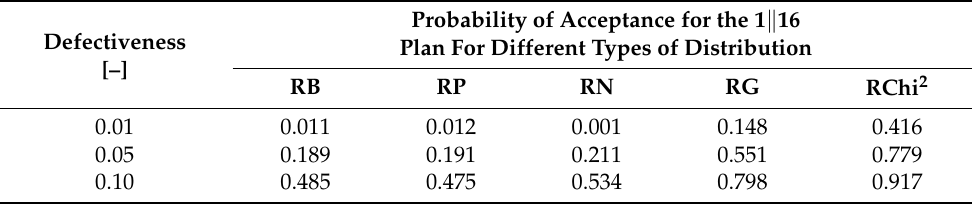
Table 2. Number of rejected lots (1-P (w)) according to Table 1 for 1 (cid:107) 16 plan.